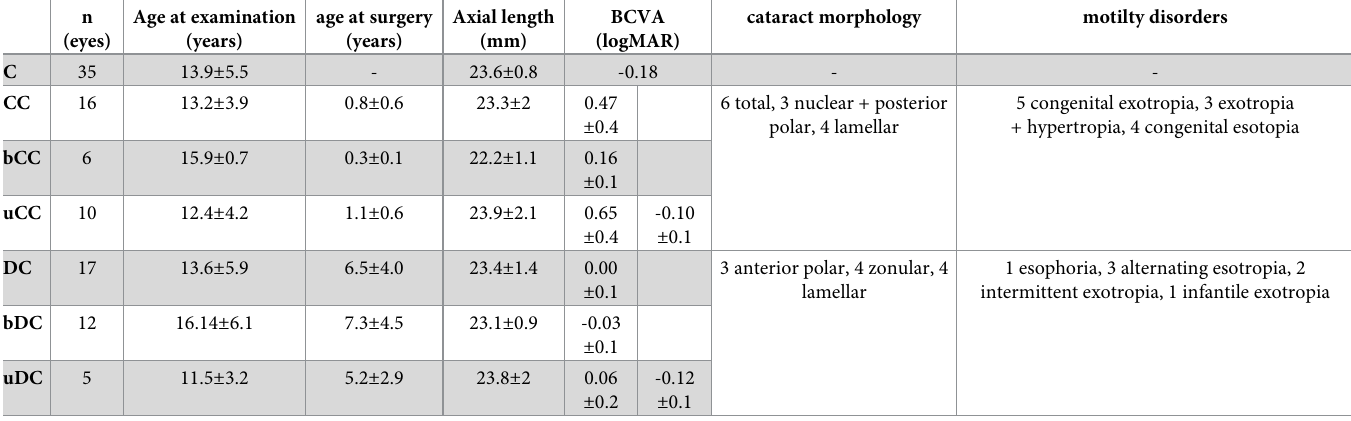
Table 1. Demographic and clinical data. n Age at examination (eyes)